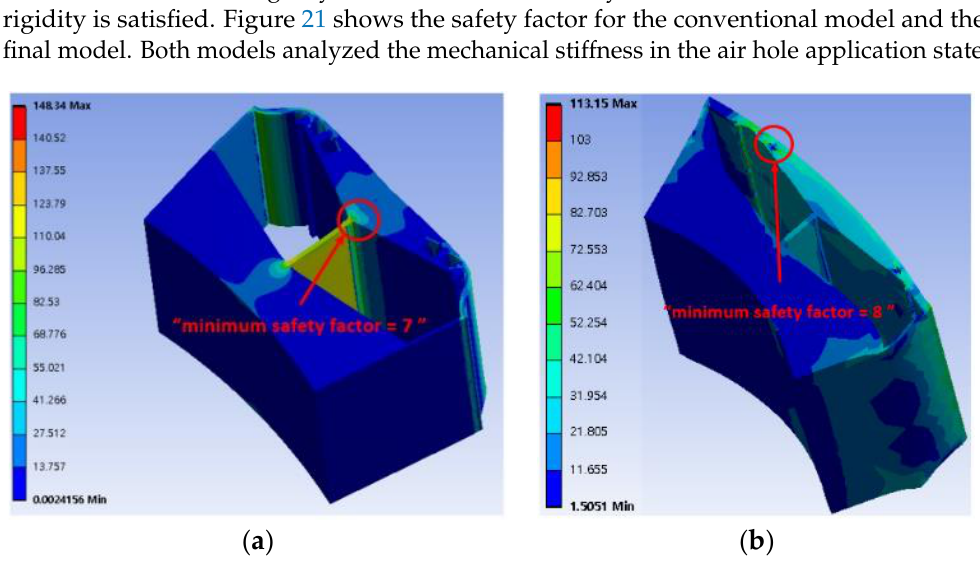
Figure 21. Mechanical stiffness in conventional model and final model: ( a ) conventional model; ( b ) final model.